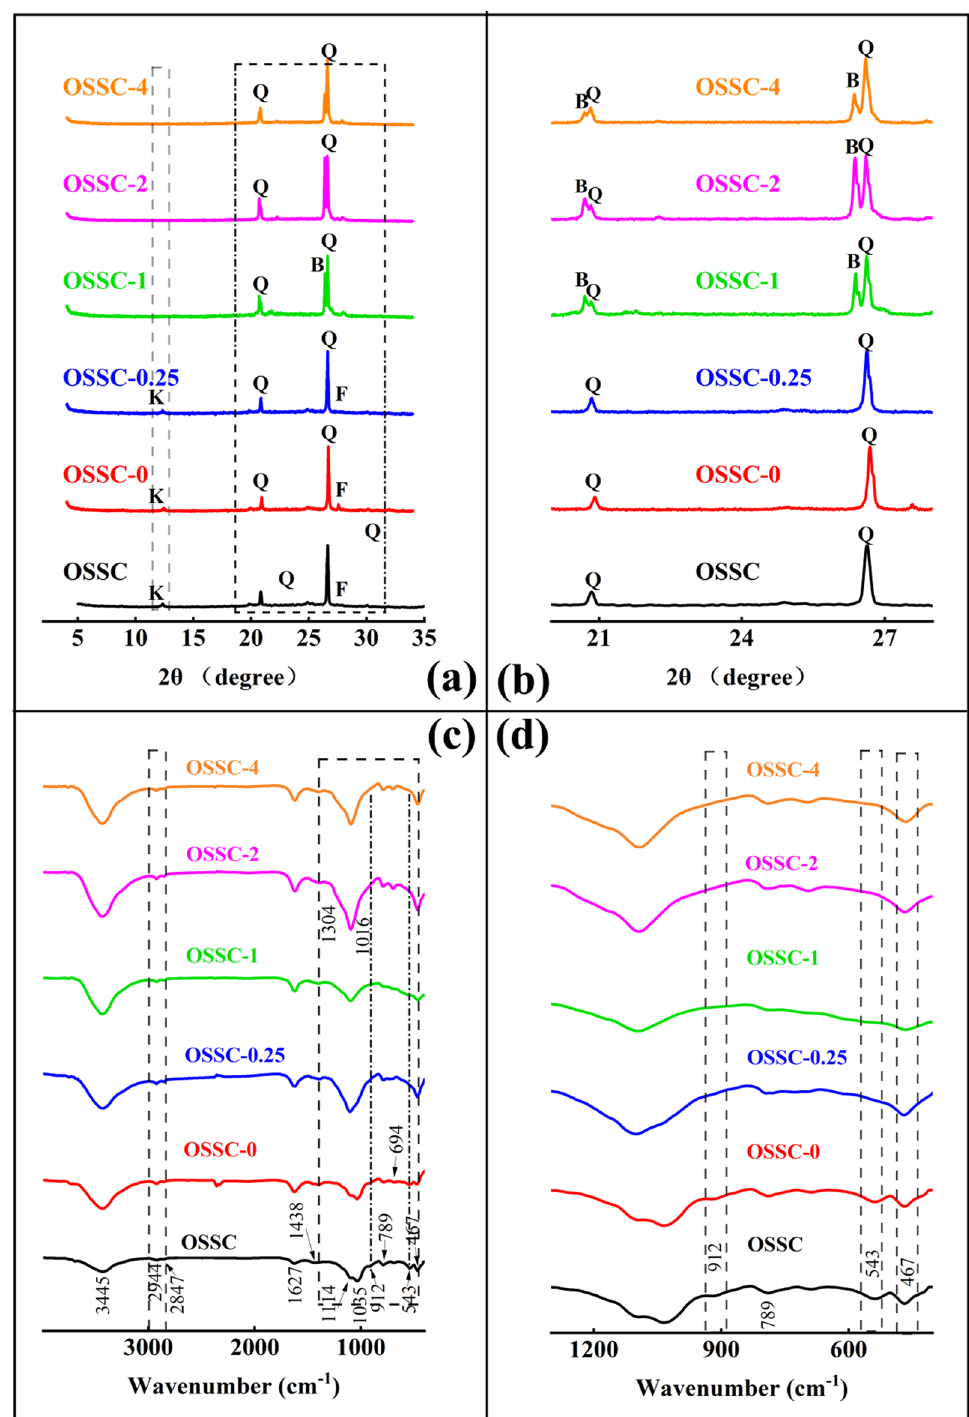
Fig. 2 a XRD patterns of OSSC before and after modification at 5° ~ 35°, b local magnification at 20°–28°, c FT-IR spectra of OSSC before and after modification at 4000 cm − 1 –400 cm − 1 , d local magnification at 1300 cm − 1 –400 cm − 1 (Q, K, F and B denoted quartz, kaolinite, feldspar and aluminum phosphate,